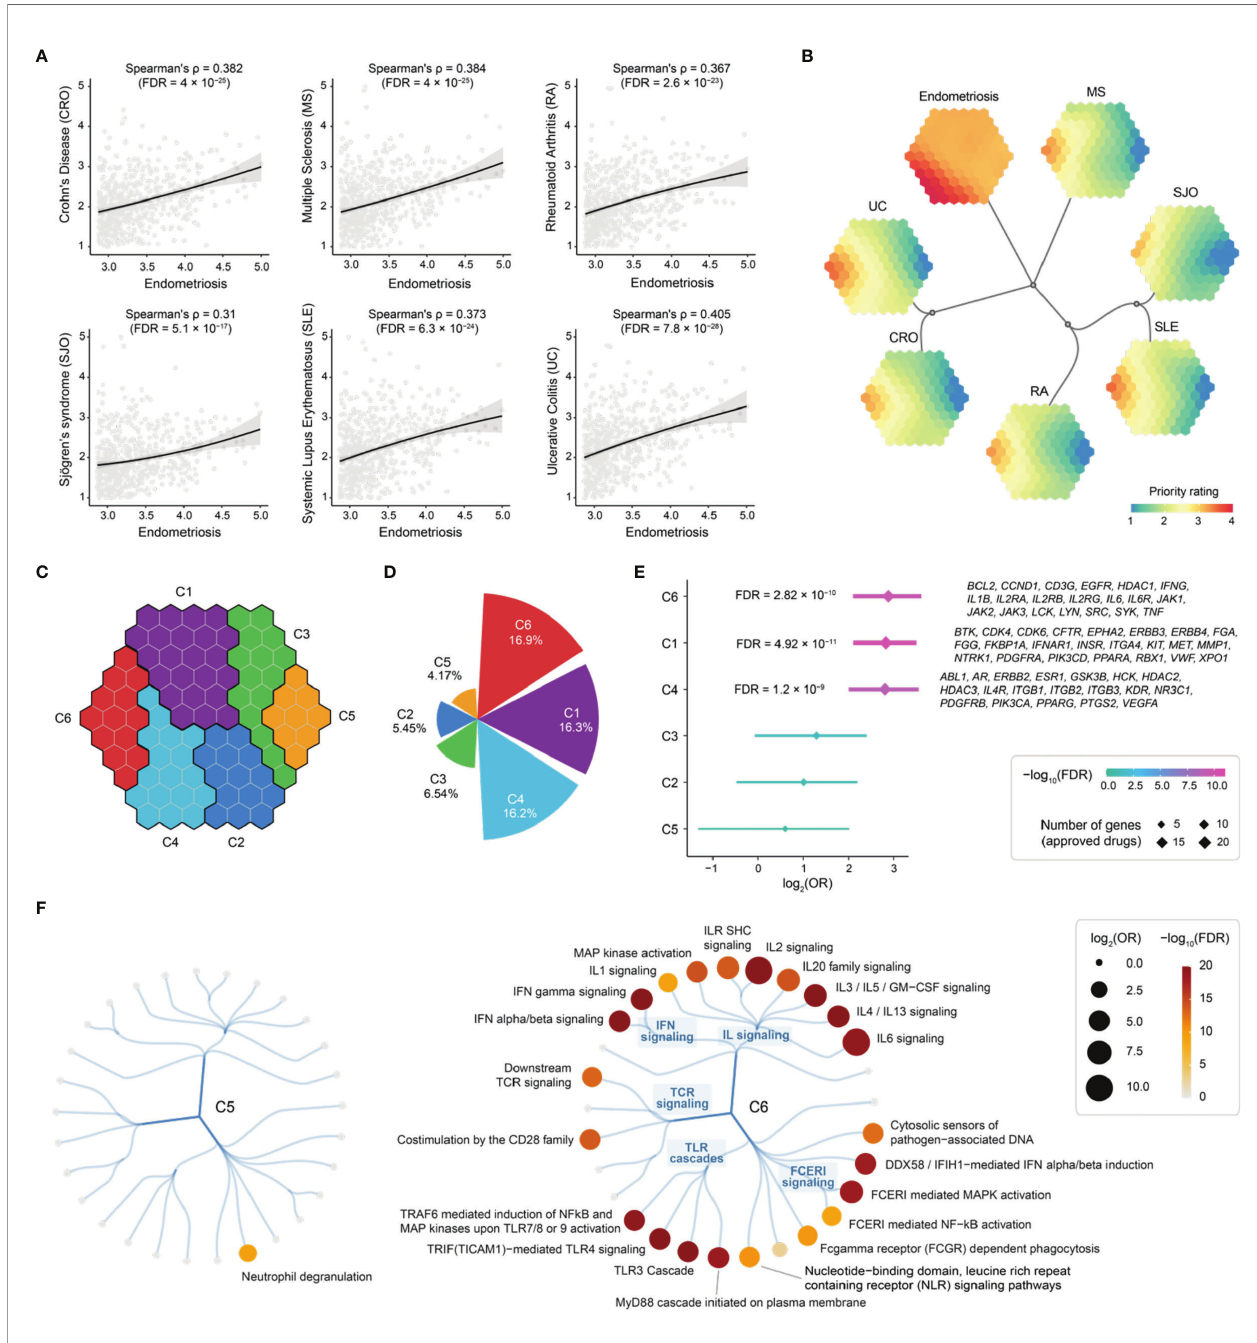
FIGURE 8 | Cross-disease prioritization map between endometriosis and immune-mediated diseases identi fi es shared and distinct target gene clusters. (A) Scatter plots showing priority rating between endometriosis (x-axis) and immune diseases (each indicated in y-axis). Spearman ’ s rank correlation calculated, with the signi fi cance level (FDR) accounting for multiple tests. Such correlation was calculated based on the top 5% prioritized genes (n = 689) in endometriosis. (B) Prioritization map. Learned using a supra-hexagonal map to compare prioritizations between endometriosis and immune diseases. Each map illustrates a disease-speci fi c gene prioritization pro fi le, while consensus neighbor-joining tree captures the similarity of inter-disease prioritization pro fi les. (C) Target gene clusters. The prioritization map divided into 6 clusters (C1-C6), each covering continuous hexagons as color-coded. (D) Polar bar summarizing the percentage of approved drug targets per cluster. (E) Forest plot of approved drug target enrichments. (F) Pathway enrichments for C5 (left) and C6 (right). Reactome immune-related pathways are organized circularly, with each dot representing a pathway, sized by odds ratio (OR) and colored by FDR. FCER1, Fc epsilon receptor 1; GM-CSF, granulocyte- macrophage colony-stimulating factor; IFIH1, interferon induced with helicase C domain 1; IFN, interferon; IL, interleukin; ILR, interleukin receptor; SHC, Src homology 2-domain-containing; TCR, T-cell receptor; TLR, toll-like